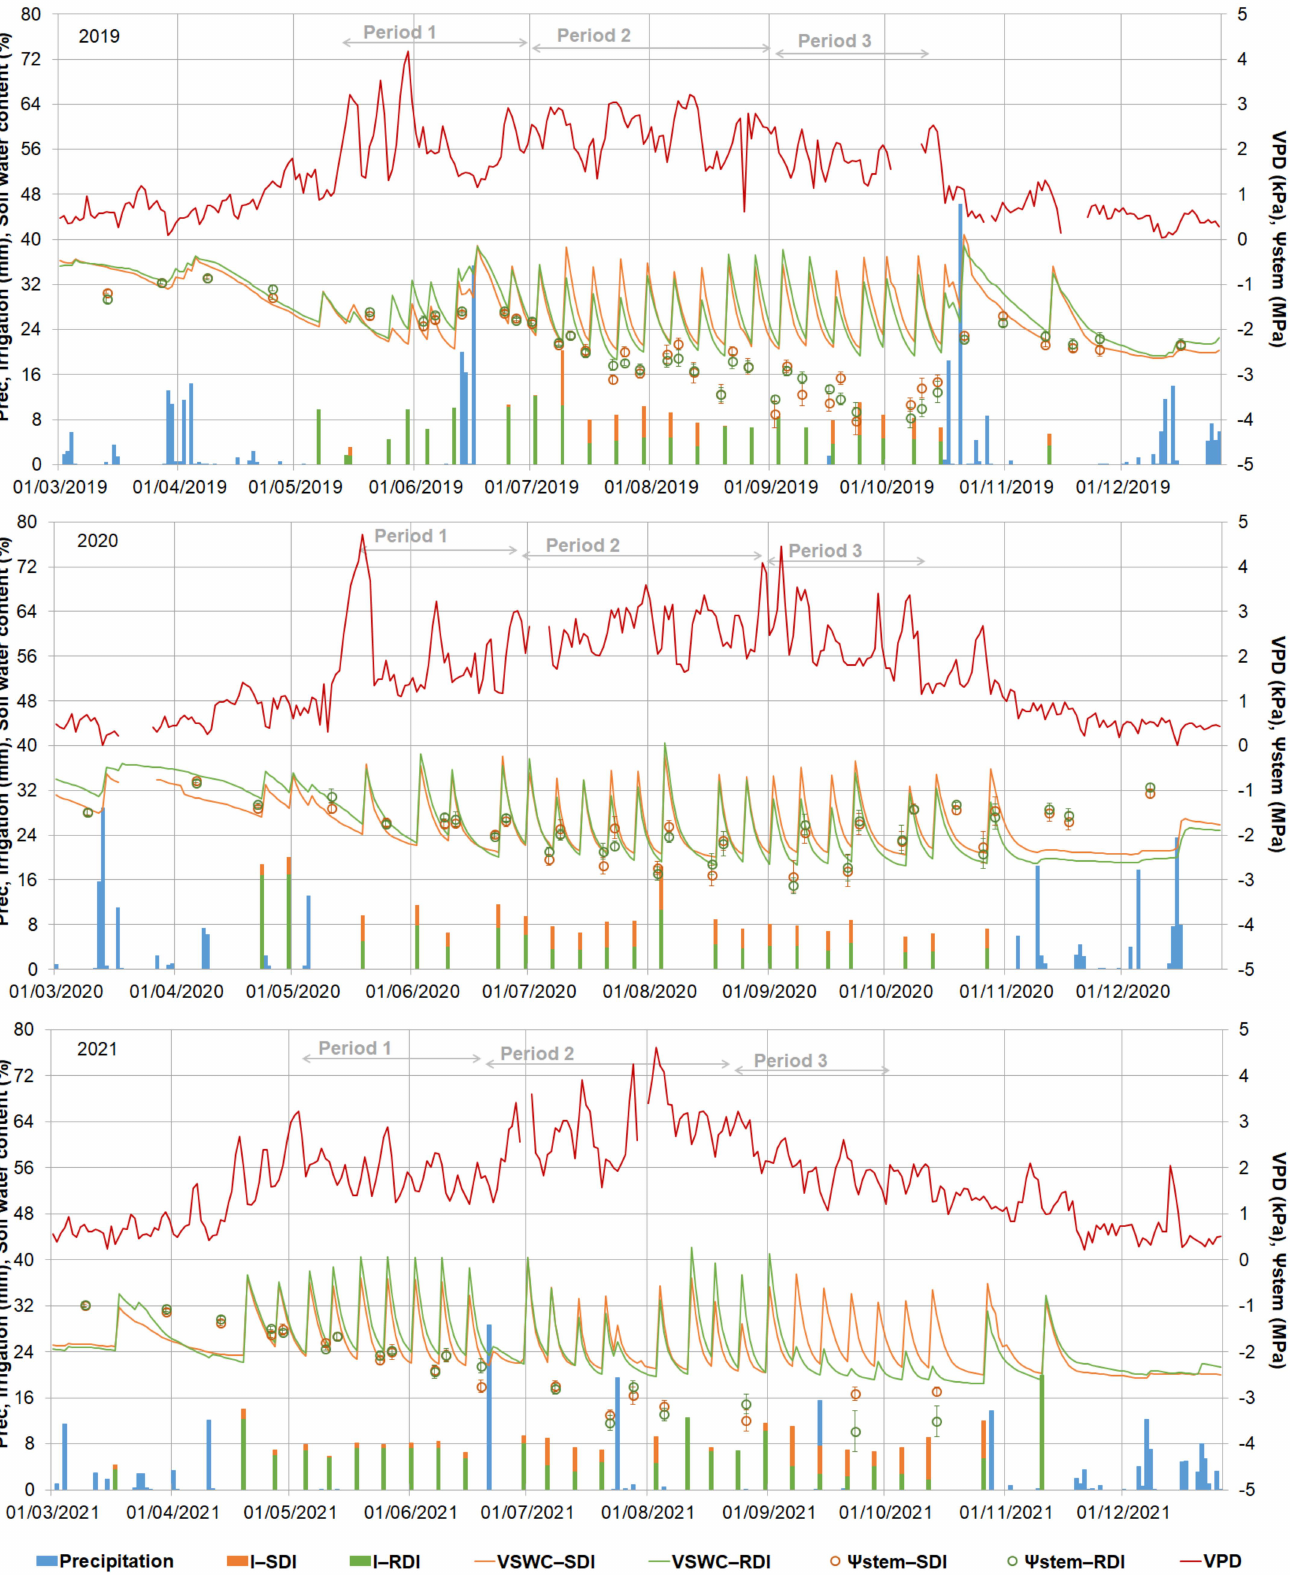
Figure 1. Precipitation, irrigation, VPD, average soil water content of the 70 cm rootzone of two replicate plots and average stem water potential ( Ψ s ) for five replicate plots for sustained (SDI) and regulated (RDI) deficit irrigation treatments, during two “on” years (2019, 2021) and an “off” year (2020). Growth periods are indicated with grey arrows at the